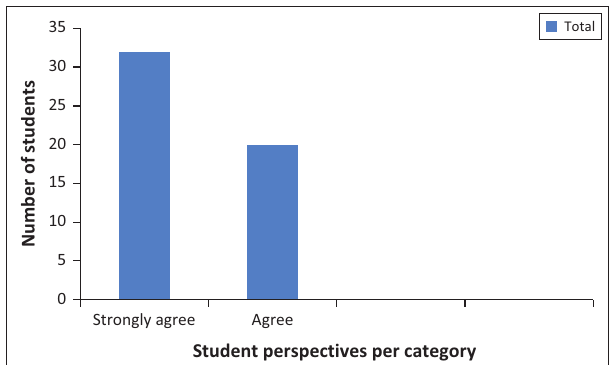
FIGURE 5: Post-workshop understanding of the assignment topic.